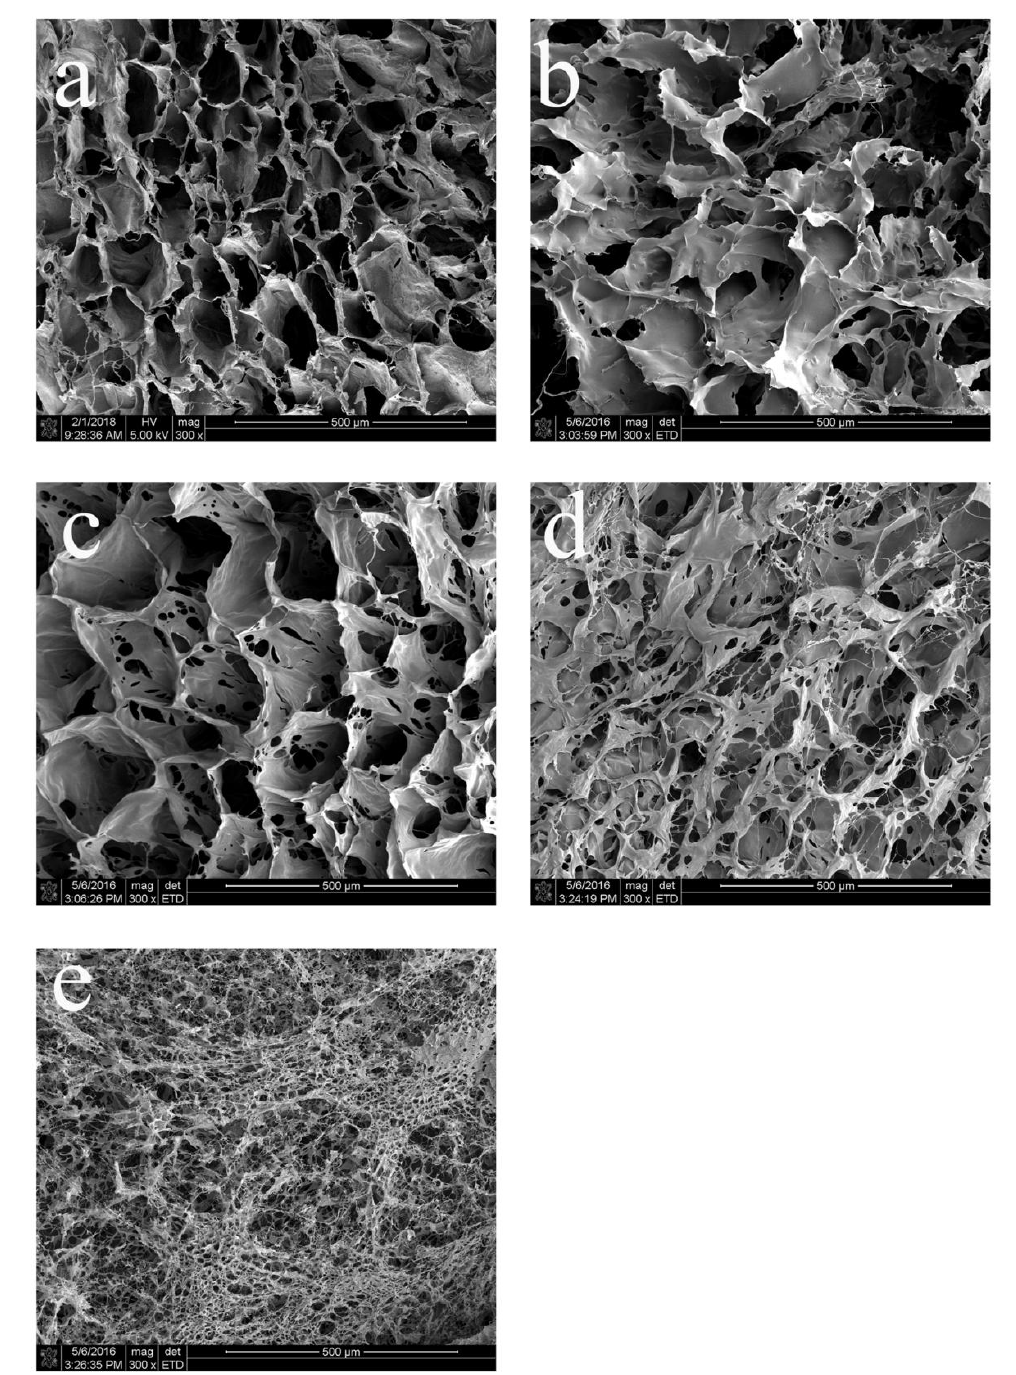
Figure 9. FESEM images (scale bar = 500 µ m) of native collagen ( a ), and collagen cross-linked by the SiO 2 /DAC hybrid materials: collagen cross-linked by DAC ( b ); collagen cross-linked by SiO 2 /DAC(1/10) ( c ); collagen cross-linked by SiO 2 /DAC(1/2) ( d ); and collagen cross-linked by SiO 2 ( e ).